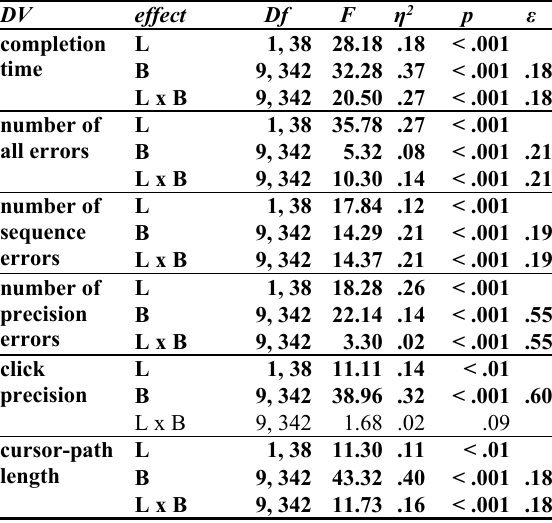
Table 5. ANOVA results of the learning phase of Experiment